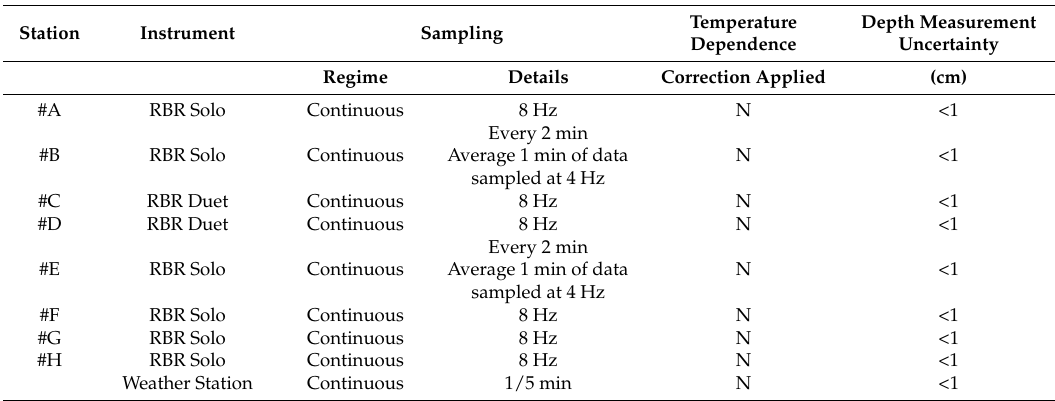
Table 2. The Tauranga instrument